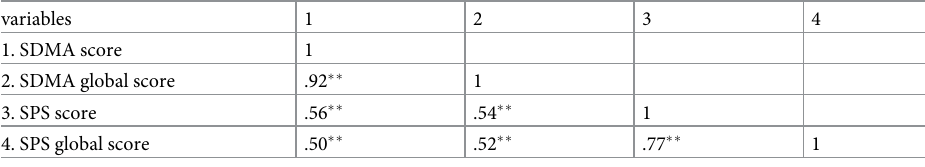
Table 4. The associations among various OSCE assessment tools.